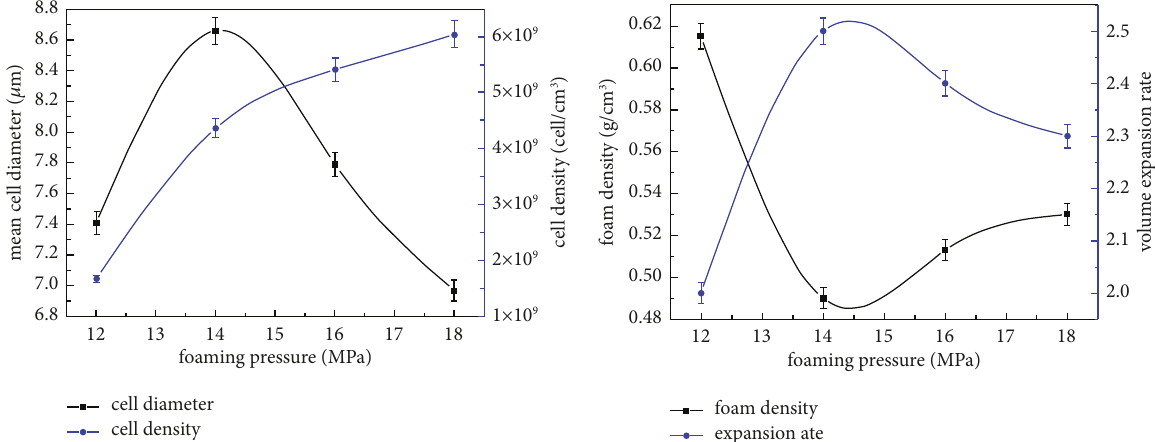
Figure 9: Effect of different foaming pressure on foaming of composites (2h, 110 °